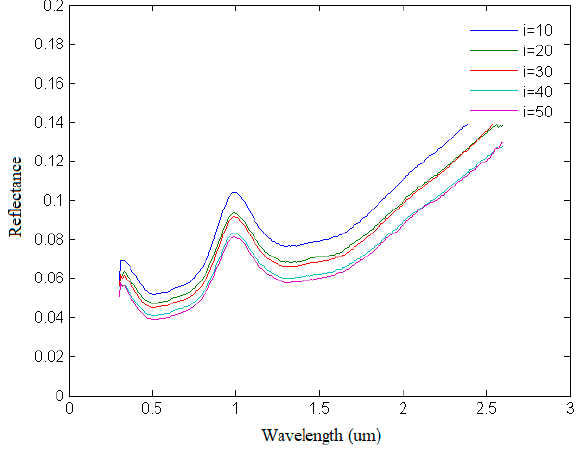
Figure 6. Measured multi-angle spectral data of ilmenite (i.e., incidence angle, emittance angle and azimuth angle).